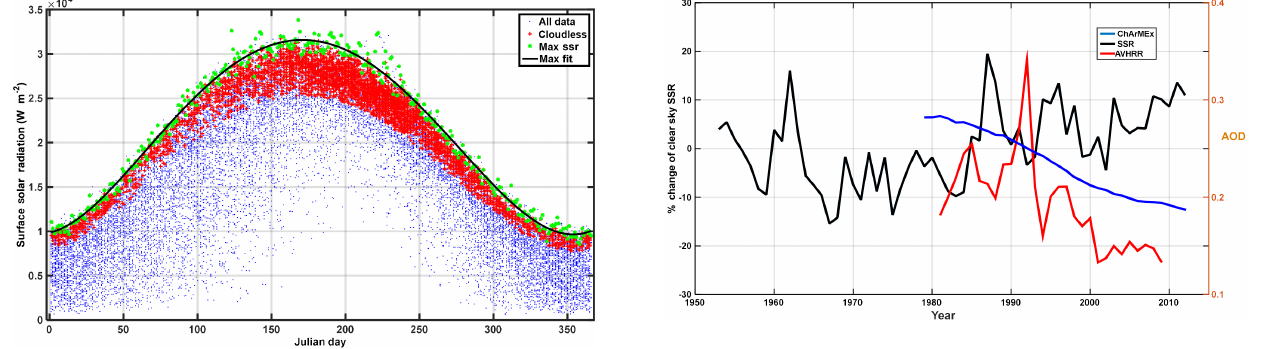
Figure 9. Clear-sky SSR measurements (red dots) and all-sky SSR measurements (blue dots) derived with the cloud octa (cloudiness < 1 . 5) and sunshine-duration-related criteria (SD > 0 . 9). The black line represents the polynomial fit to the daily SSR max values.